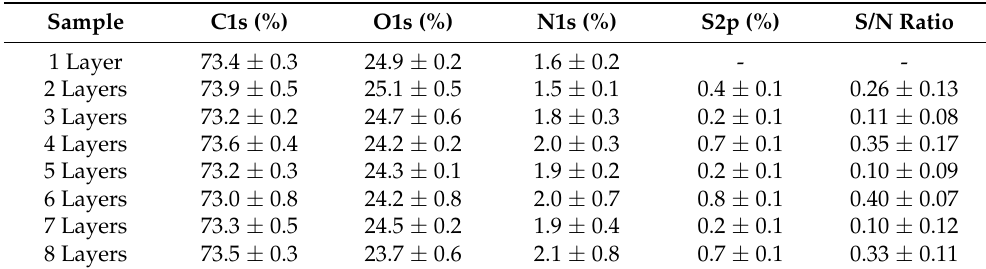
Figure 3. XPS survey spectra of the functionalised porous scaffold after the obtainment of 8 nanolayers. Table 1. Atomic concentration (%) of the characteristic elements present in the multilayer after Layer-by-layer assembly on the 3D porous glass-ceramic scaffolds.